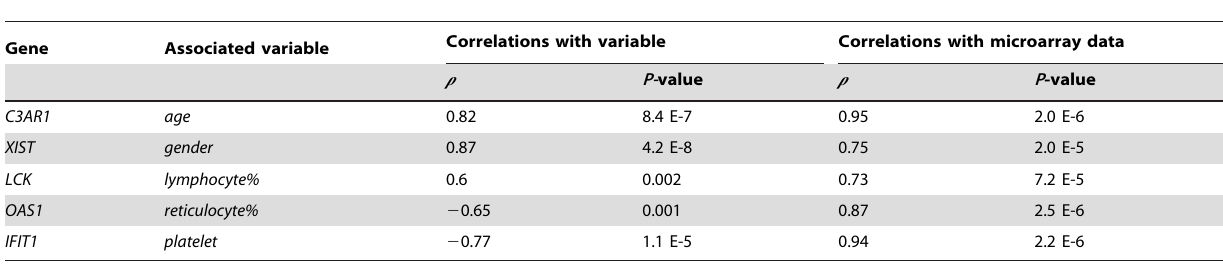
Table 3. Validation of microarray data by real-time PCR.